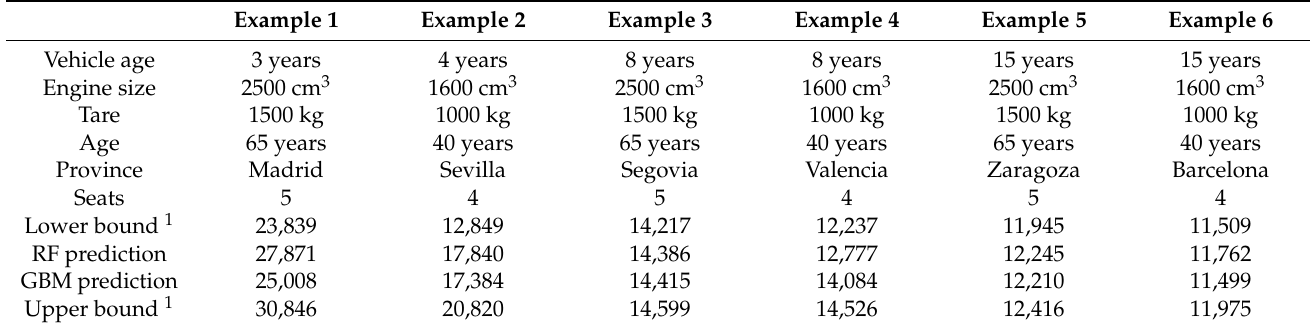
Table 6. Prediction